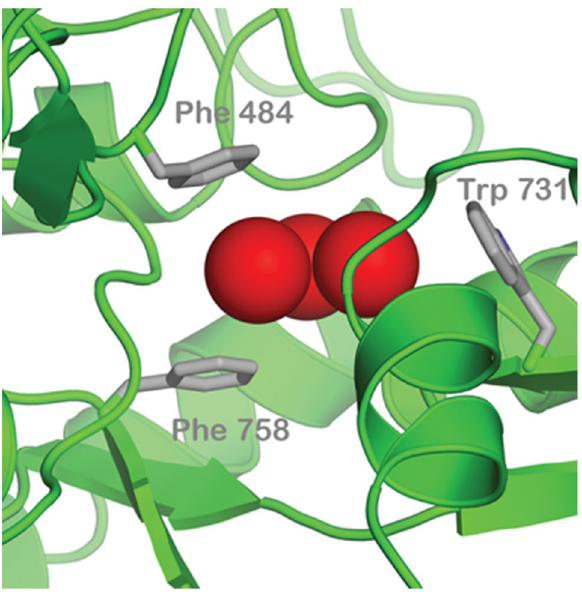
Figure 1. The image shows the predicted position of xenon atoms (red spheres) in the glycine site of the NMDA receptor, together with the aromatic residues phenylalanine 758, phenylalanine 484, and tryptophan 731 28